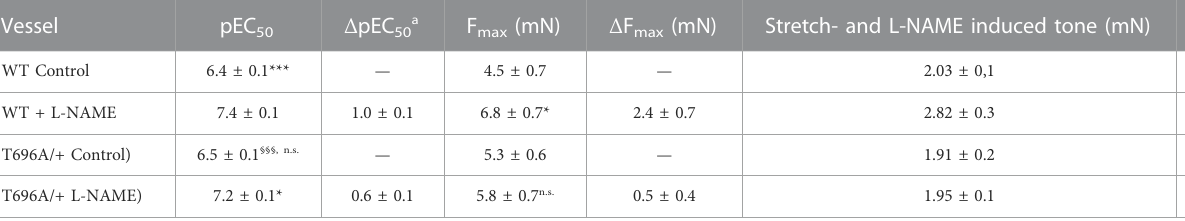
TABLE 1 Contractile parameters of intact preparations from young basilar arteries from wild type (WT) and heterozygous (MYPT1-T696A/+) mice. Vessel